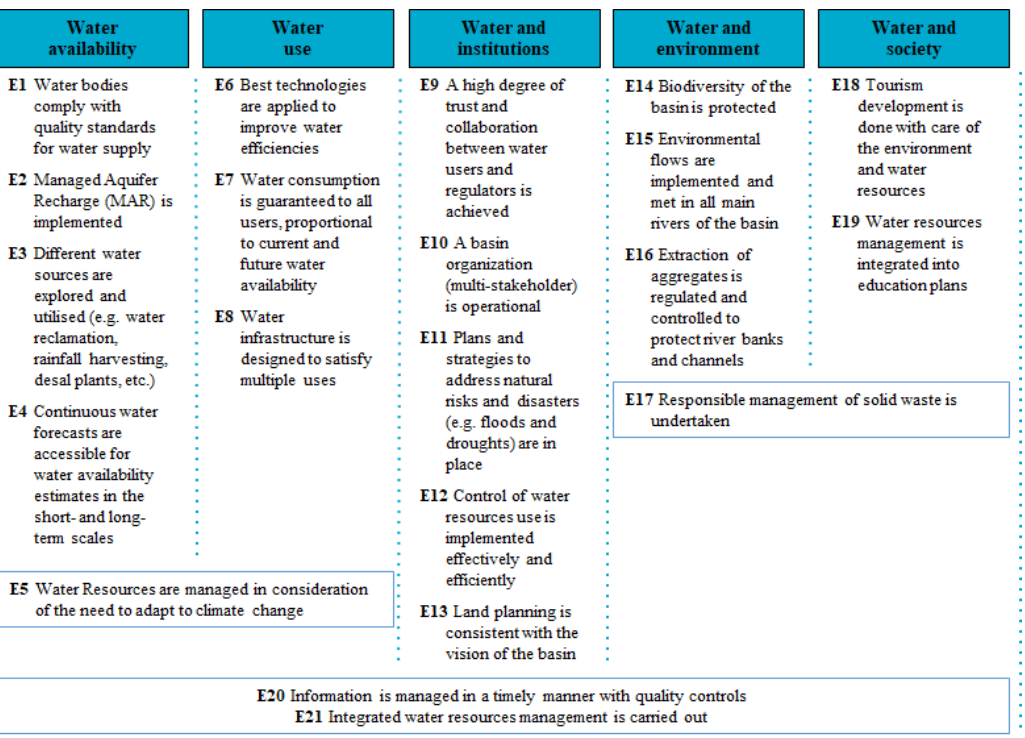
Figure 6. Description of the elements of the shared vision used in the SNA for the